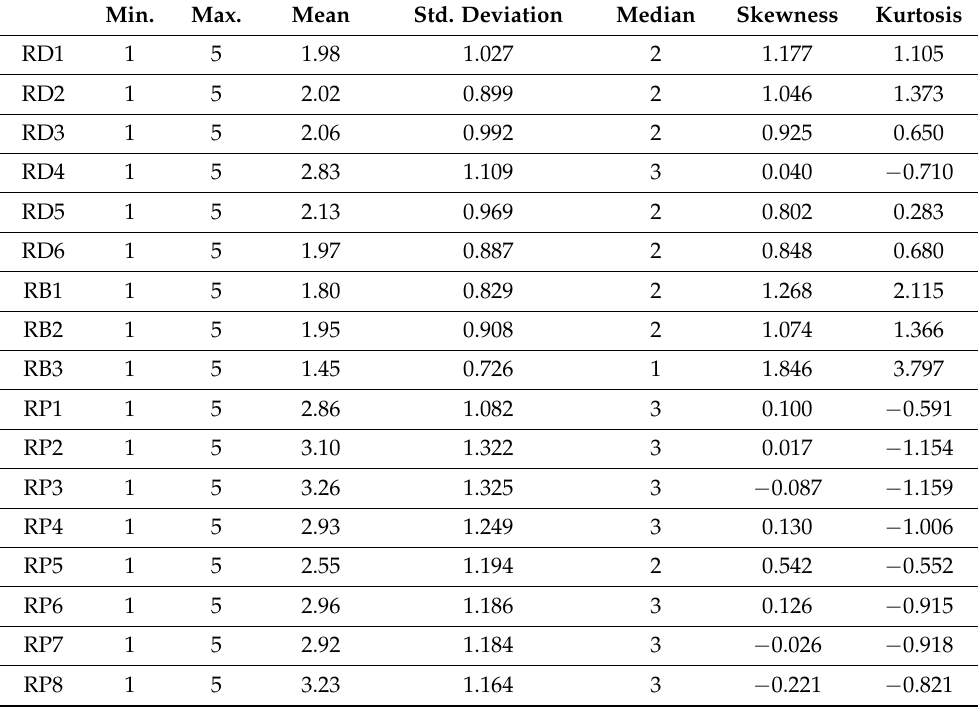
Table A1. Summary Statistics of